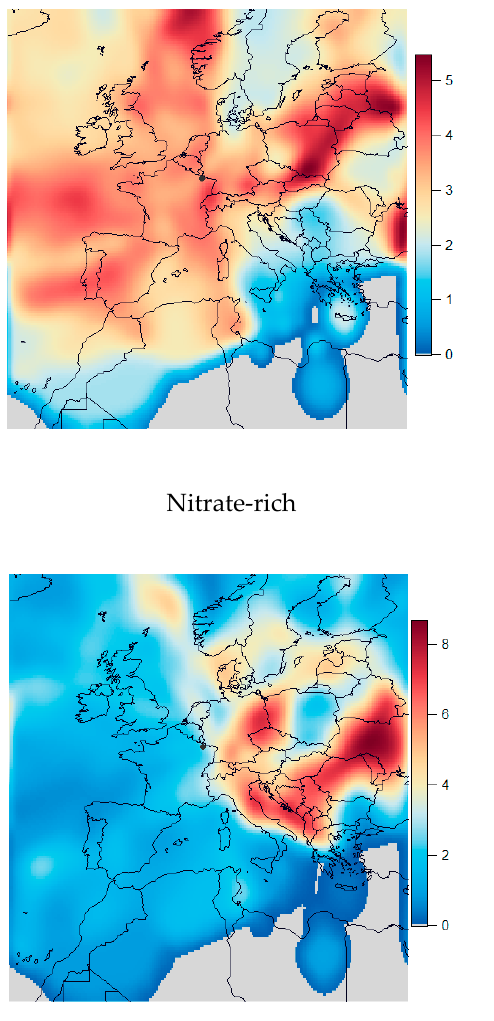
Figure 5. CWT analysis of oxalate-rich, sulfate-rich and nitrate-rich factors. Red colors highlight potential emission zones. Scales are in µg/m 3 .